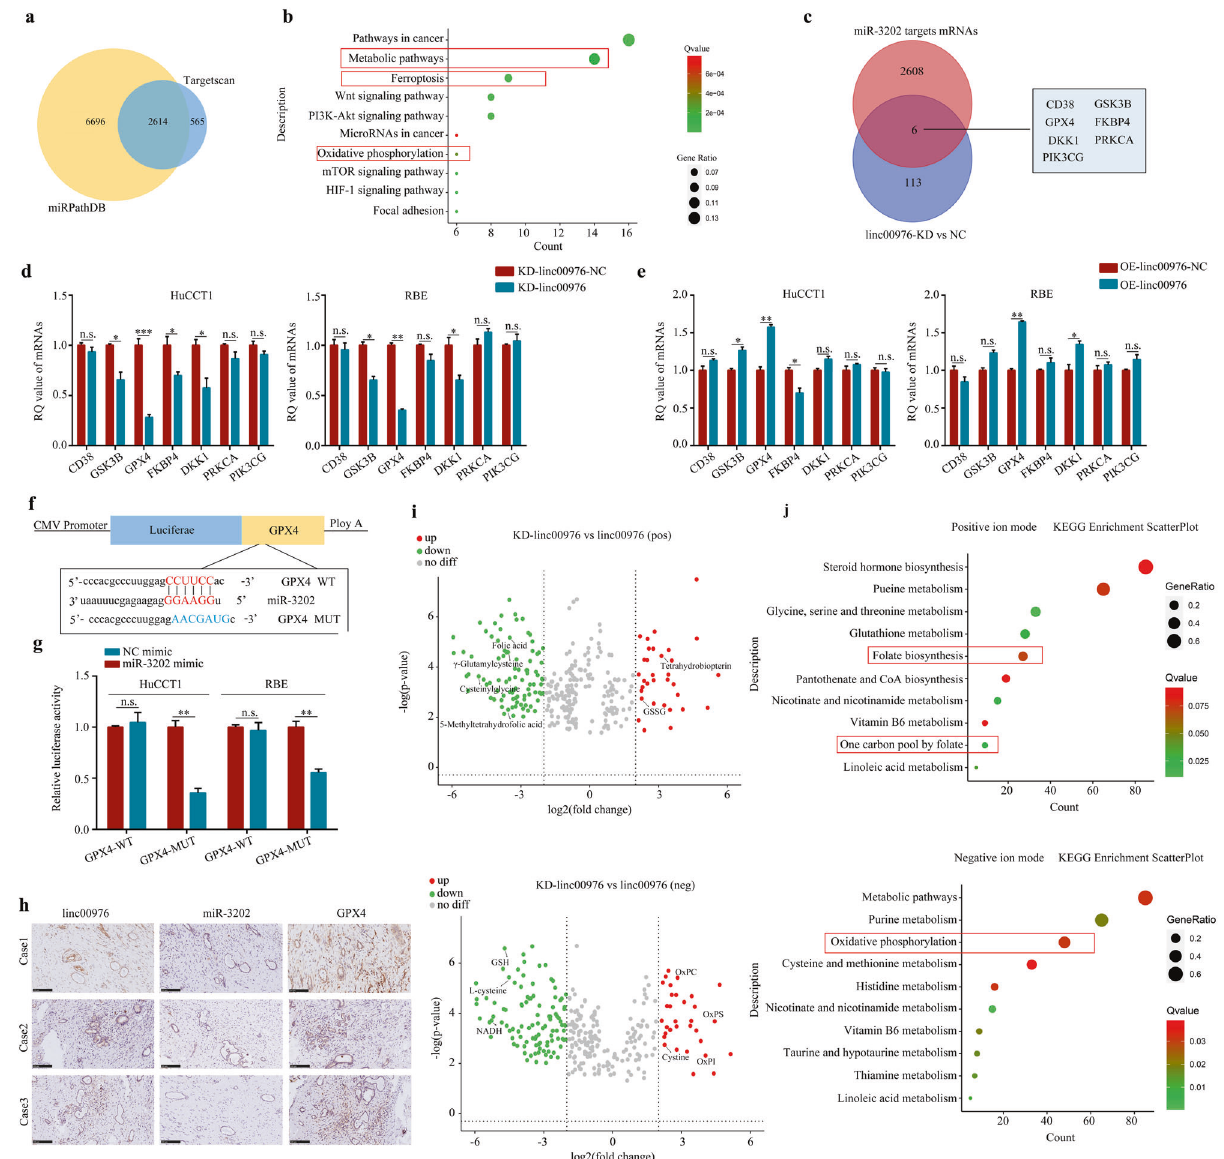
Fig. 6 linc00976 positively regulates GPX4 expression via sponging miR-3202 in CCA cells. a Schematic illustration showing overlapping of the target mRNAs of miR-3202 predicted by TargetScan and miRPathDB. b The downregulated mRNAs were subjected to KEGG enrichment analysis. c Venn diagram showing overlapping of target mRNAs and downregulated mRNAs of miR-3202. d RT-qPCR showed the mRNA levels of six candidate genes in CCA cells transfected with KD-linc00976 or KD-linc00976-NC. e RT-qPCR showed the mRNA levels of six candidate genes in CCA cells transfected with OE-linc00976 or OE-linc00976-NC. f The putative binding sites between miR-3202 and GPX4. g The luciferase activities were detected in CCA cells after co-transfection with GPX4-WT or GPX4-MUT and miR-3202 mimics or NC mimics. h IHC images showed the co-expression of linc00976, miR-3202, and GPX4. Scale bar, 100 μ m. i Volcano plots demonstrating altered metabolite levels. Metabolites associated with GSH metabolism and folate biosynthesis are signi fi cantly downregulated, while oxidized phospholipids are signi fi cantly upregulated. j KEGG enrichment analysis of differentially abundant metabolites identi fi ed in negative and positive ion modes, respectively. n.s. not signi fi cant, * P < 0.05, ** P < 0.01. CCA cholangiocarcinoma, GSH glutathione, IHC immunohistochemistry, KEGG Kyoto Encyclopedia of Genes and Genomes, RT-qPCR reverse transcription-quantitative